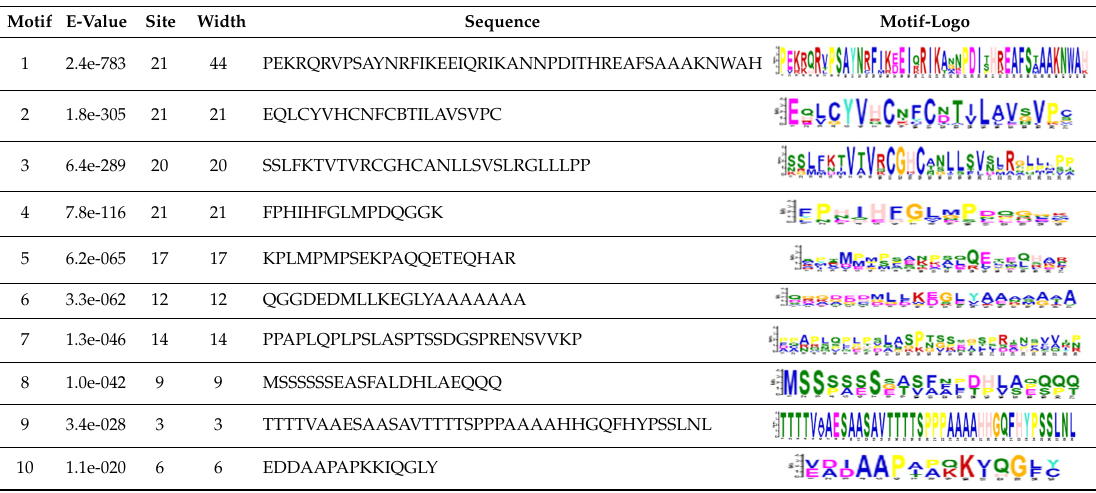
Table 2. Identified motif of TaYABBY -genes.